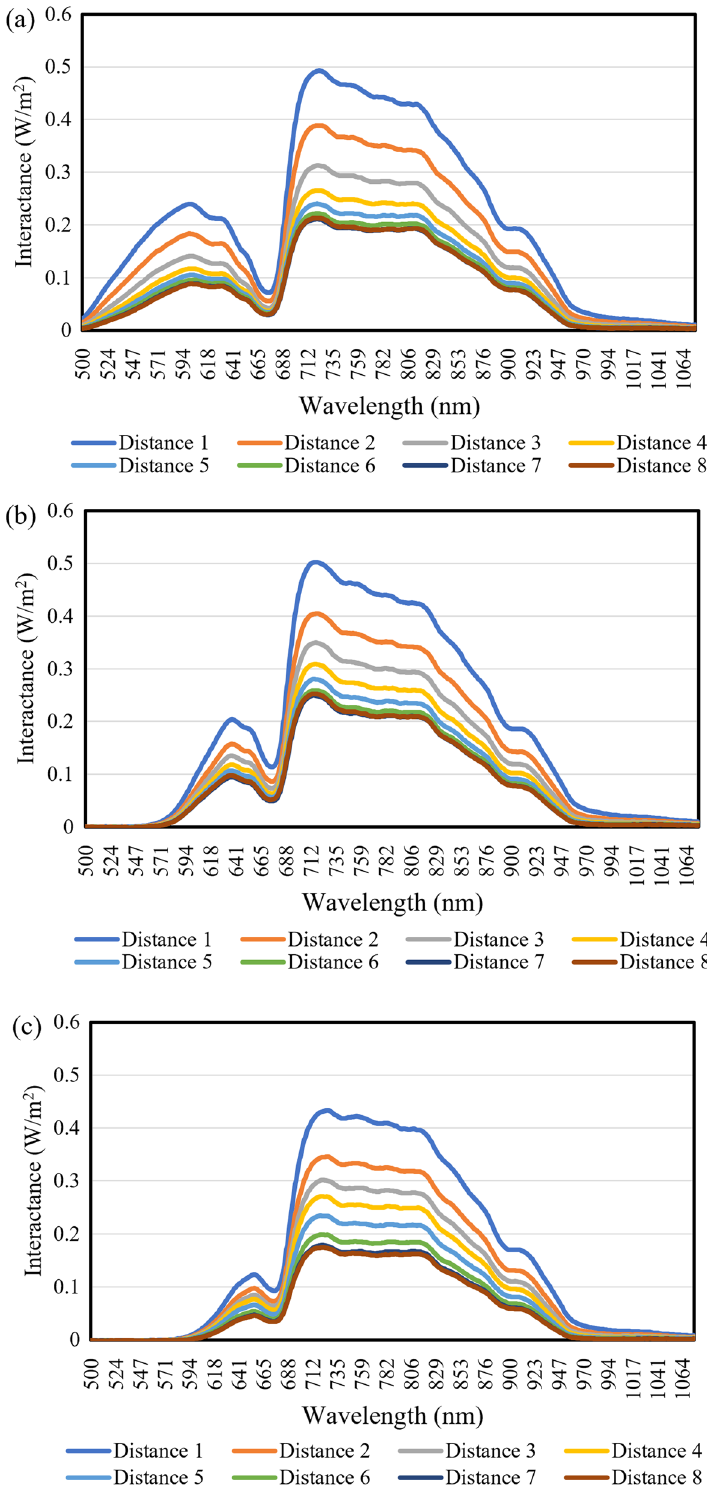
Figure 5. Spectral characteristics of interactances obtained at different positions for fruit samples with different levels of anthocyanin contents. The averaged whole flesh anthocyanin contents of the low ( a ), medium ( b ), and high ( c ) anthocyanin content fruits were 0.094, 0.5513 and 1.416 mg/100 g,